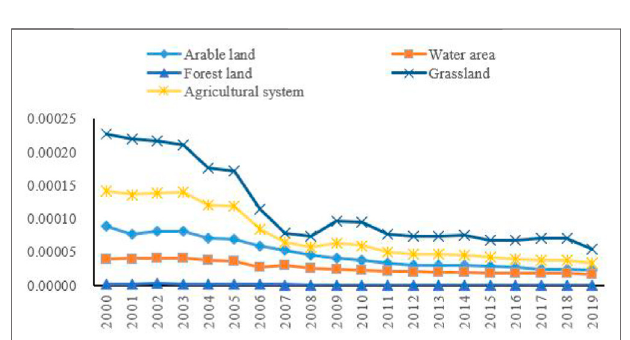
FIGURE 11 | WEF of lands in Sichuan from 2000 to